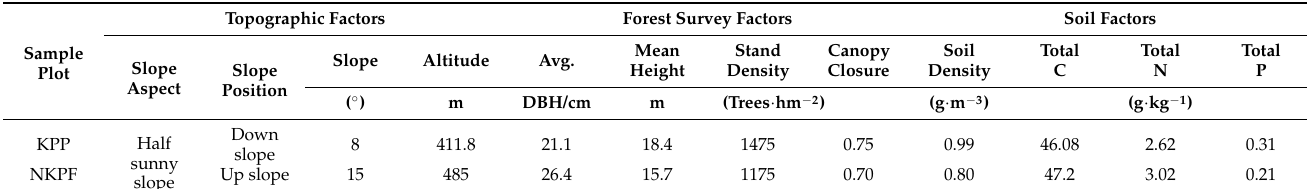
Table 1. Summary of basic characteristics of the investigated